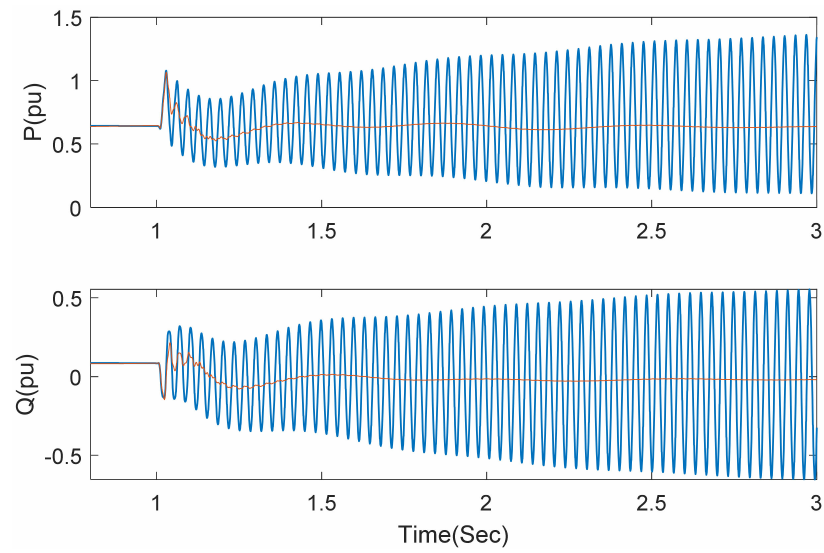
Figure 10. Active and reactive responses under PI (blue) and the proposed method (red), with wind speed of 7 m/s and series-compensated level of 60%.